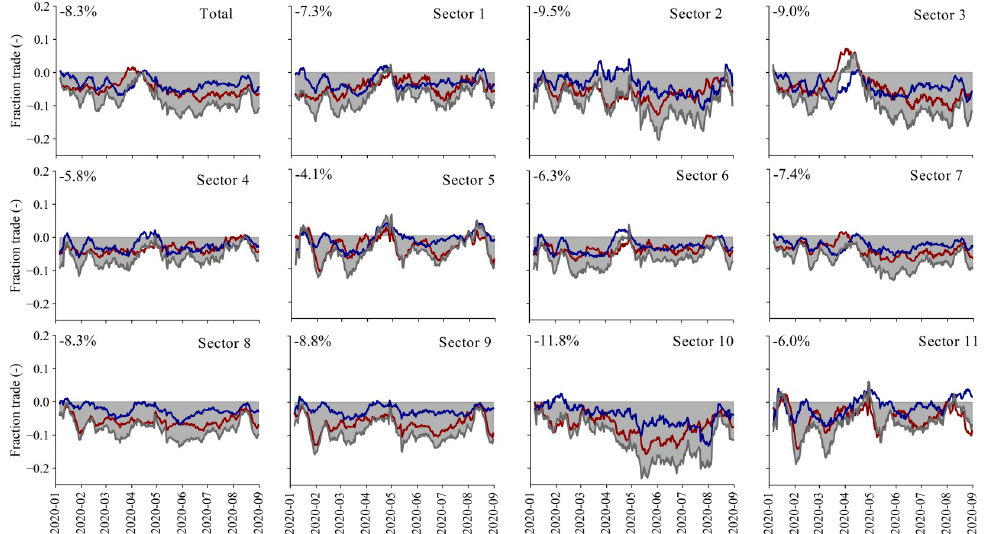
Fig 3. Sector-specific losses over time. The change in daily global total trade as a fraction of the average daily trade (over 2019). The dark blue line represent imports, the dark red line represent exports, whereas the grey line indicate total trade (import + exports). Sector 1: Agriculture; Sector 2: Fishing; Sector 3: Mining and quarrying; Sector 4: Food and beverages; Sector 5: Textiles and wearing apparel; Sector 6: Wood and paper; Sector 7: Petroleum, chemical and non-metallic mineral products; Sector 8: Metal products; Sector 9: Electrical and machinery; Sector 10: Transport equipment; Sector 11: Other